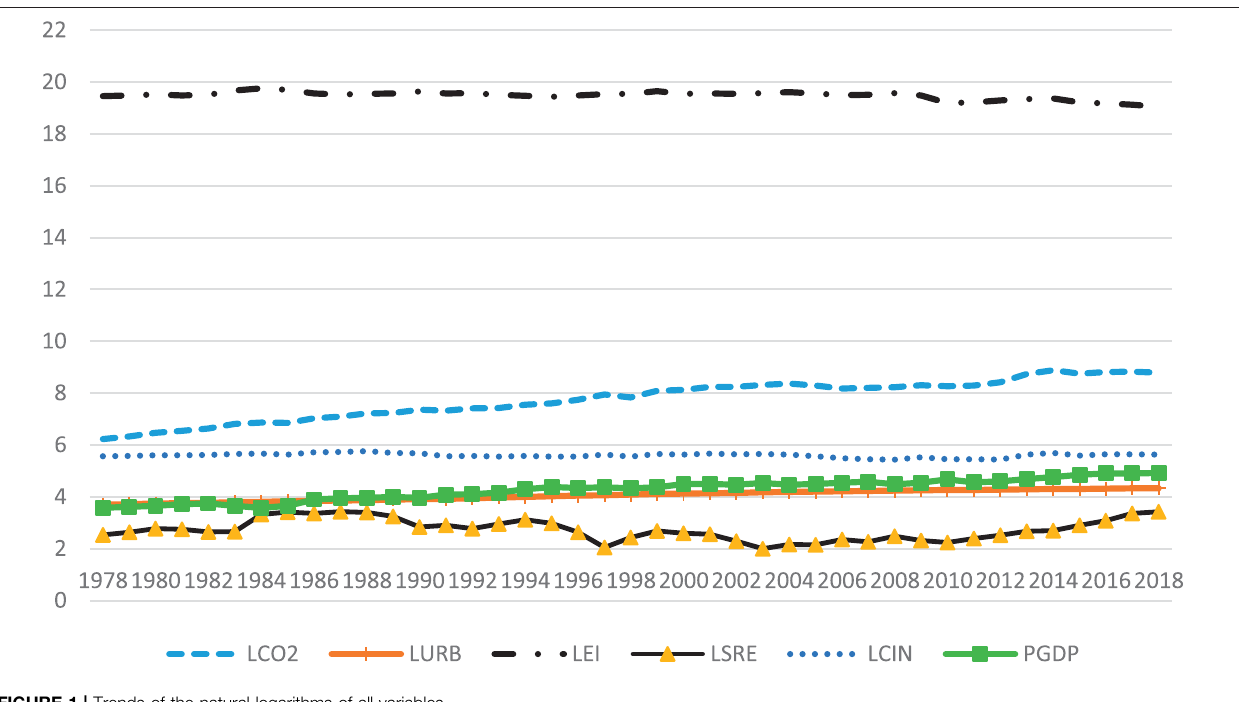
FIGURE 1 | Trends of the natural logarithms of all